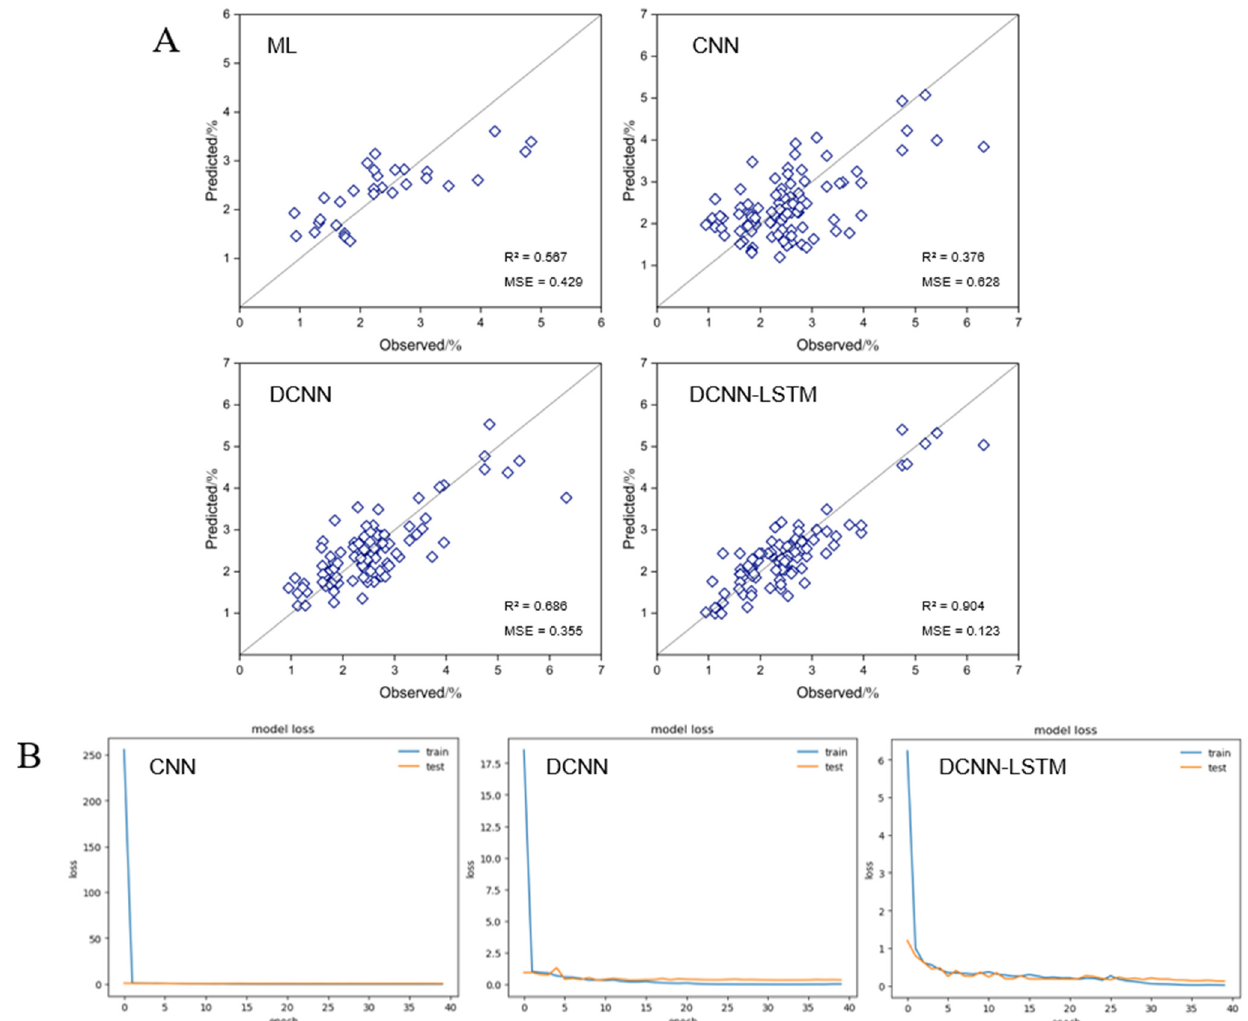
Figure 14. ( A ) Observed and predicted values. ( B ) Epoch and loss values of machine learning (ML), convolutional neural network (CNN), deep convolutional neural network (DCNN) and DCNN–long-short term memory (LSTM) model simulations.